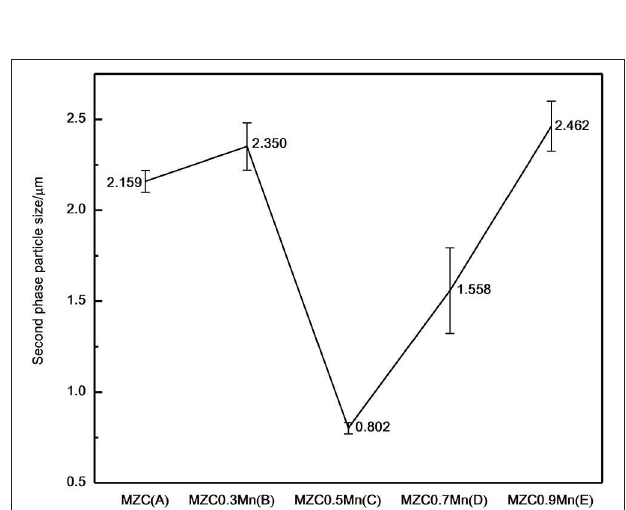
FIGURE 5 | Average particle size of spherical second phase measured by using SEM scale. (A) MZC, (B) MZC0.3Mn, (C) MZC0.5Mn, (D) MZC0.7Mn, and (E) MZC0.9